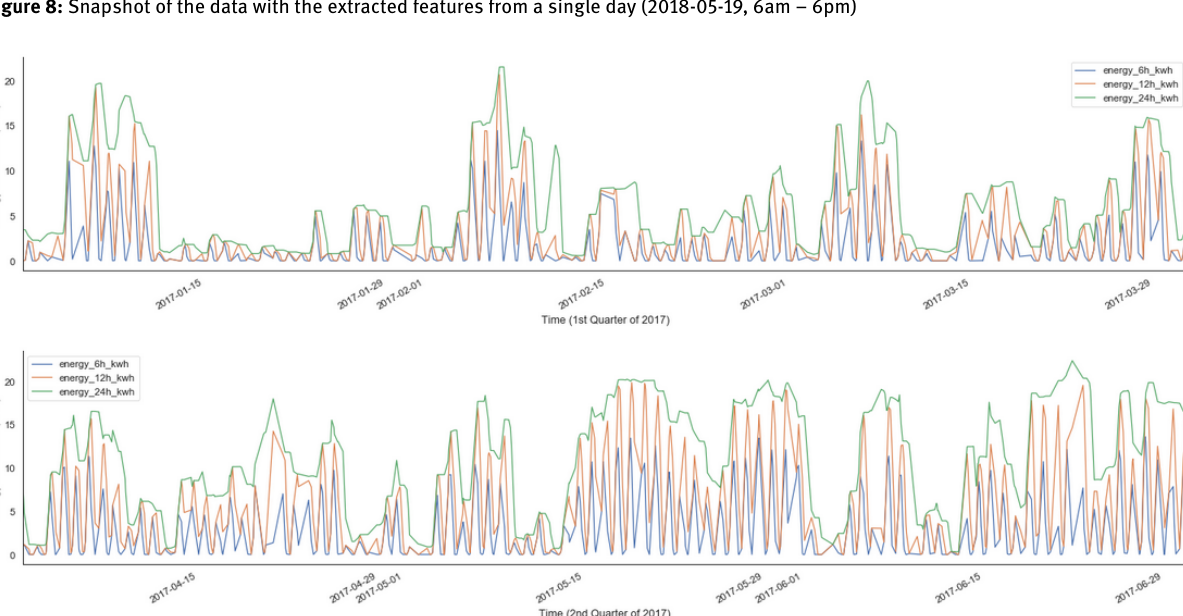
Figure 8: Snapshot of the data with the extracted features from a single day (2018-05-19, 6am – 6pm)